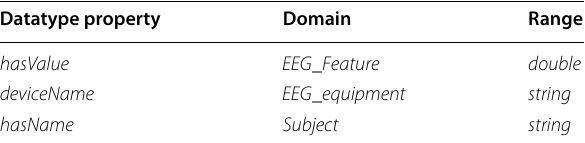
Table 2 Part of the datatype properties in portable